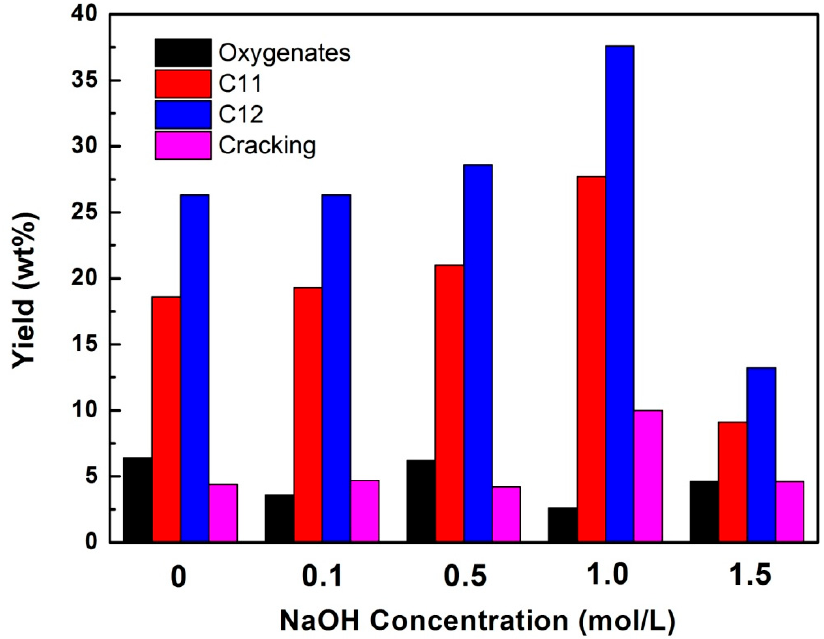
Figure 8. Yields for hydrodeoxygenation of methyl laurate in H 2 over 10 wt % Ni catalysts loaded on the hierarchical HZSM-5 treated with different concentrations of NaOH solution (0.1–1.5 M). Experimental conditions: methyl laurate (3.5 mmol), n-hexane (20 mL), catalyst (0.1 g), 280 ◦ C, 2 MPa of H 2 (Room temperature), and stirring at 600 rpm for 5 h.